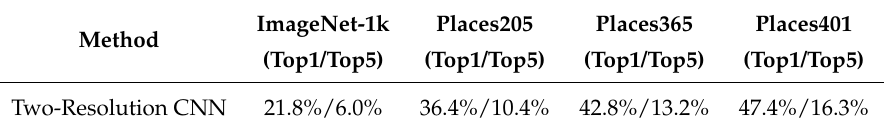
Table 2. The classification error on different datasets based on multi-resolution CNN in